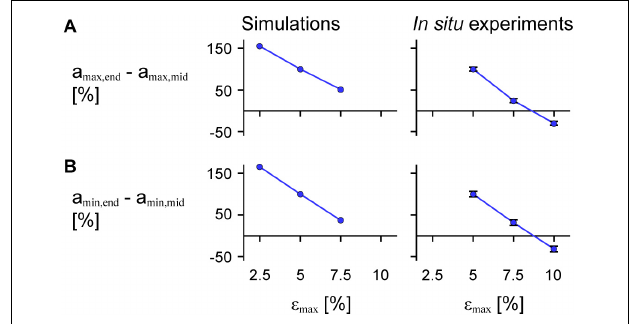
FIGURE 10 | Difference in maximum and minimum acceleration near the middle compared to at the end of the muscle across maximum strains. Mean difference in maximum normalised acceleration in the x -direction at the end a max , end compared to that of a point near the middle of the muscle a max , mid across cycle strains for simulations relative to scale 1 (left) and in situ experiments relative to 85% added muscle mass (right; p < 0.001) calculated across all scales and added masses (A) . (B) Shows the mean difference in minimum acceleration a min , end in the x -direction at the end compared to near the middle of the muscle a min , mid ( p < 0.001 for the in situ experiments). a max , end and a min , end were normalised to the muscle optimal length. a max , mid and a min , mid were normalised to the x distance between the centre point and the moving end of the muscle at rest for the simulations and between the inserted pin and the moving end of the in situ muscle at rest for the experiments. The initial pennation angle β 0 was 15.3 ◦ and the maximum normalised excitation was 1 for the simulations and the in situ muscle was supramaximally stimulated to activate all the muscle fibres. The error bars for the in situ experiments represent the standard error of the mean. Note that the lines connecting discrete points are intended to aid in visualization rather than to imply a linear relationship.